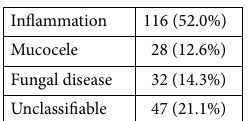
Table 3. Diagnosis groups by imaging.